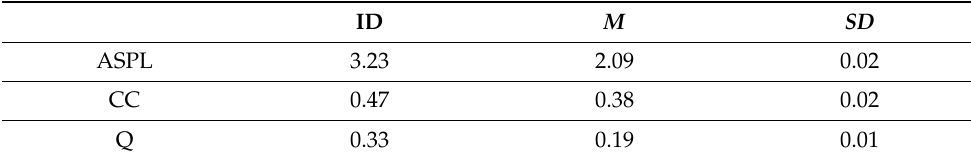
Table A4. Random Network comparison for the network of the adolescents with ID (dataset 3), p < 0.001 for all comparisons.